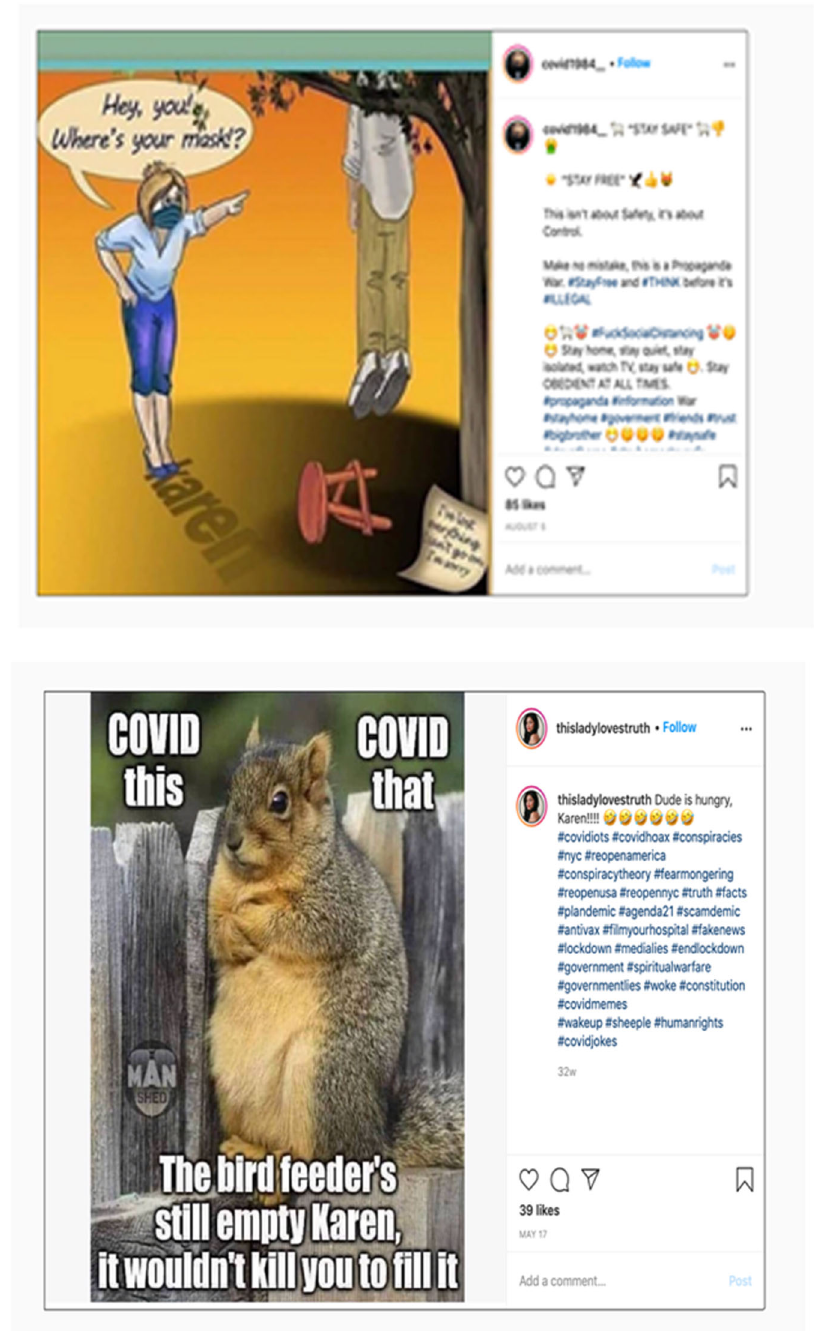
Fig. 3 Social media posts representing pejorative portrayals of “ Karen ”